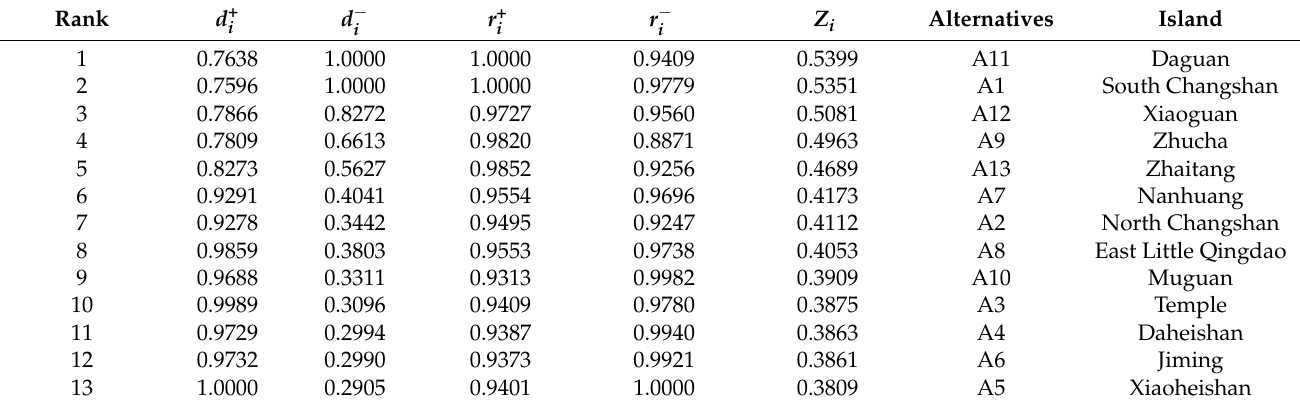
Table 6. Ranking of site alternatives.